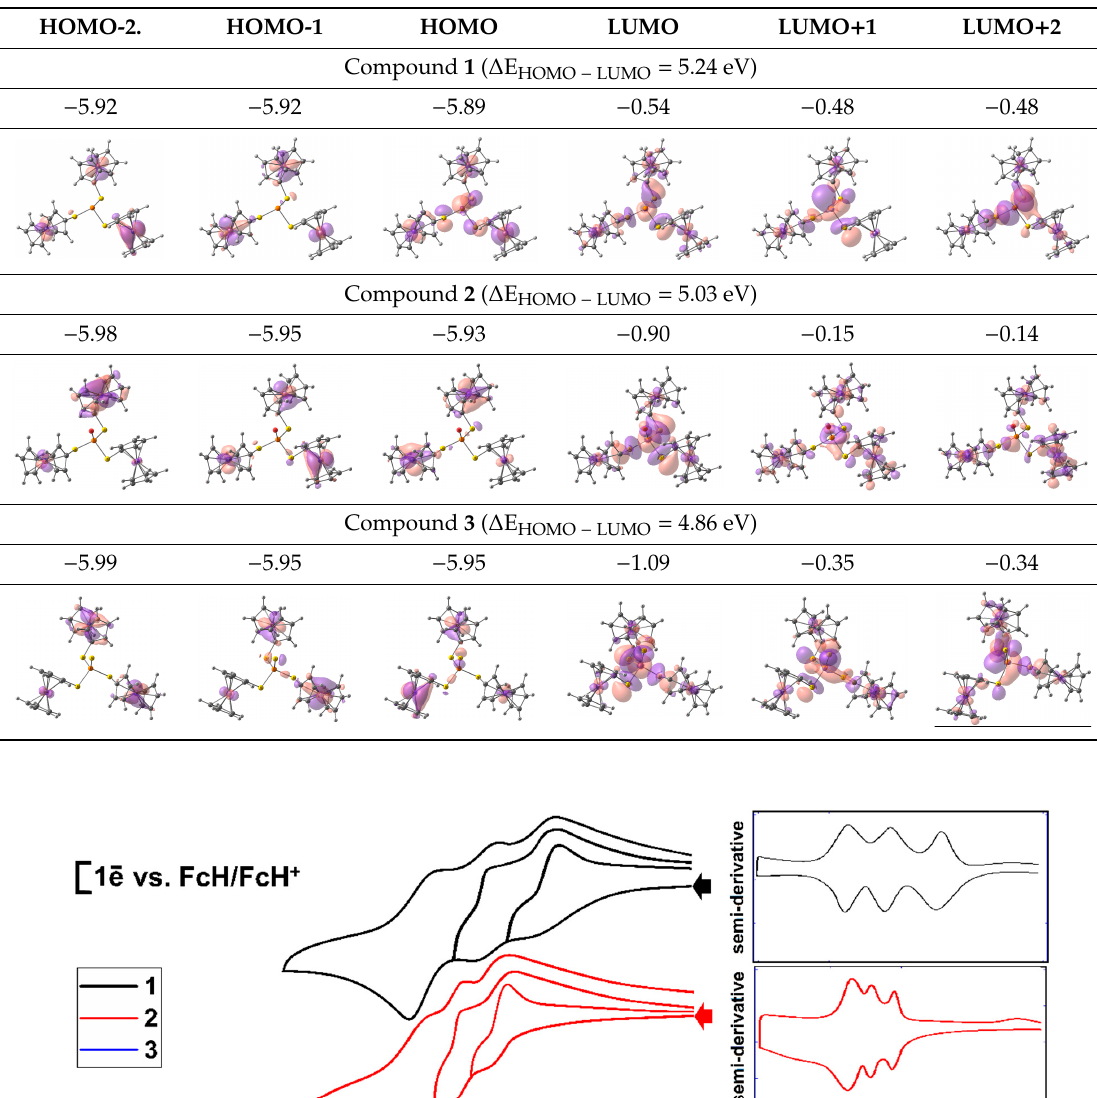
Table 1. Predicted energies of frontier orbitals of optimized compounds 1 – 3 .